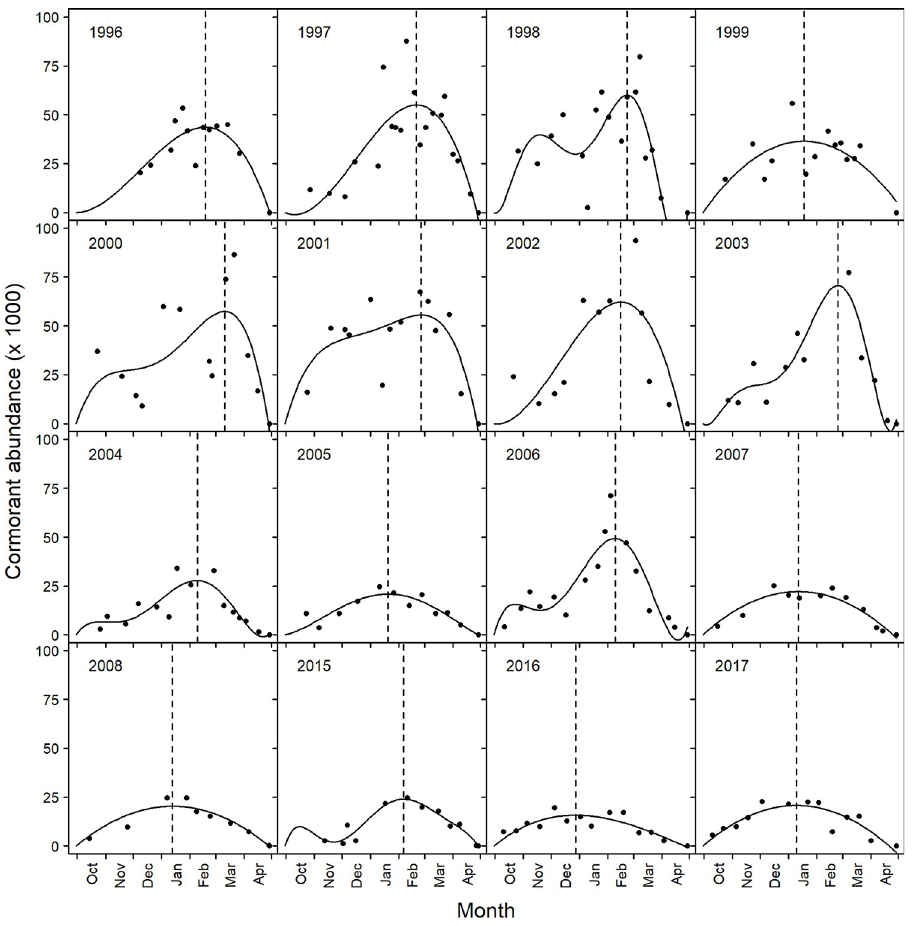
Fig 8. Modeled population trends (solid black line) of survey counts (black points) of cormorants at roosting sites in the Mississippi Delta over the winter seasons (October–April) of 1996–2008 and 2015–2017. Cormorant count was assumed to be zero at the beginning (October 01) and end (April 30) of the winter. Dashed lines indicate the date in which maximum modeled abundance is observed for each year.